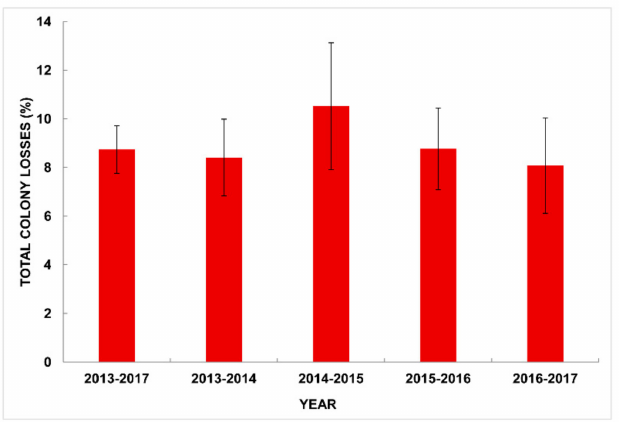
Figure 2. Total colony winter losses for the di ff erent periods of years. Means and 95% confidence intervals are